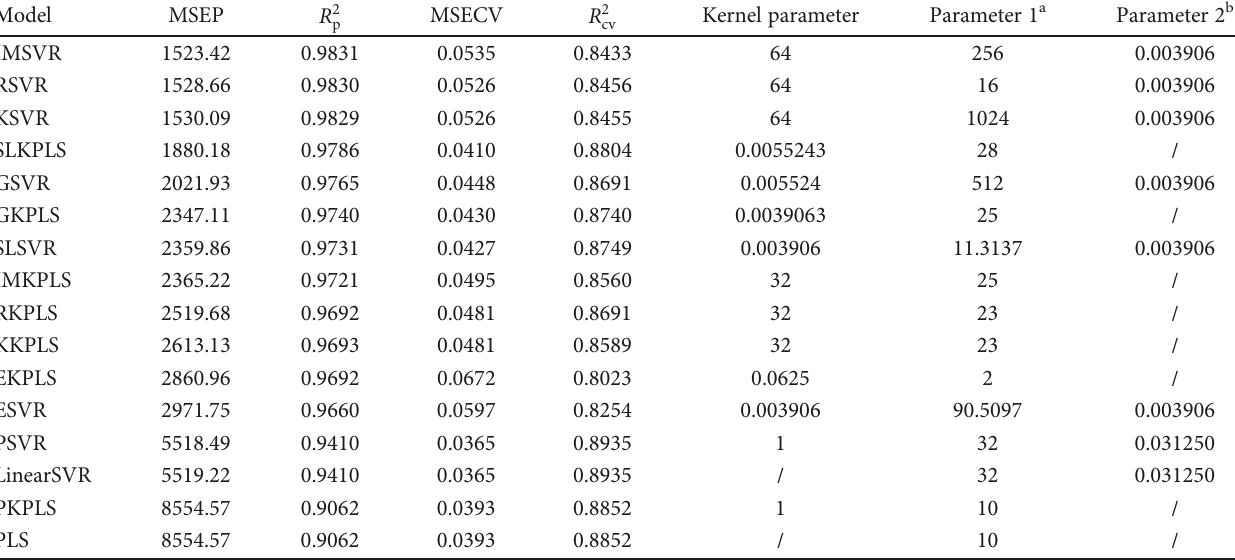
Table 1: Analytical results for UA